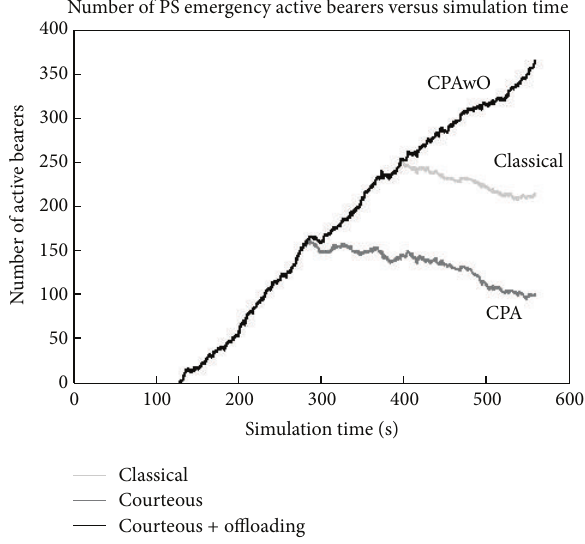
Figure 4: Number of PS emergency active